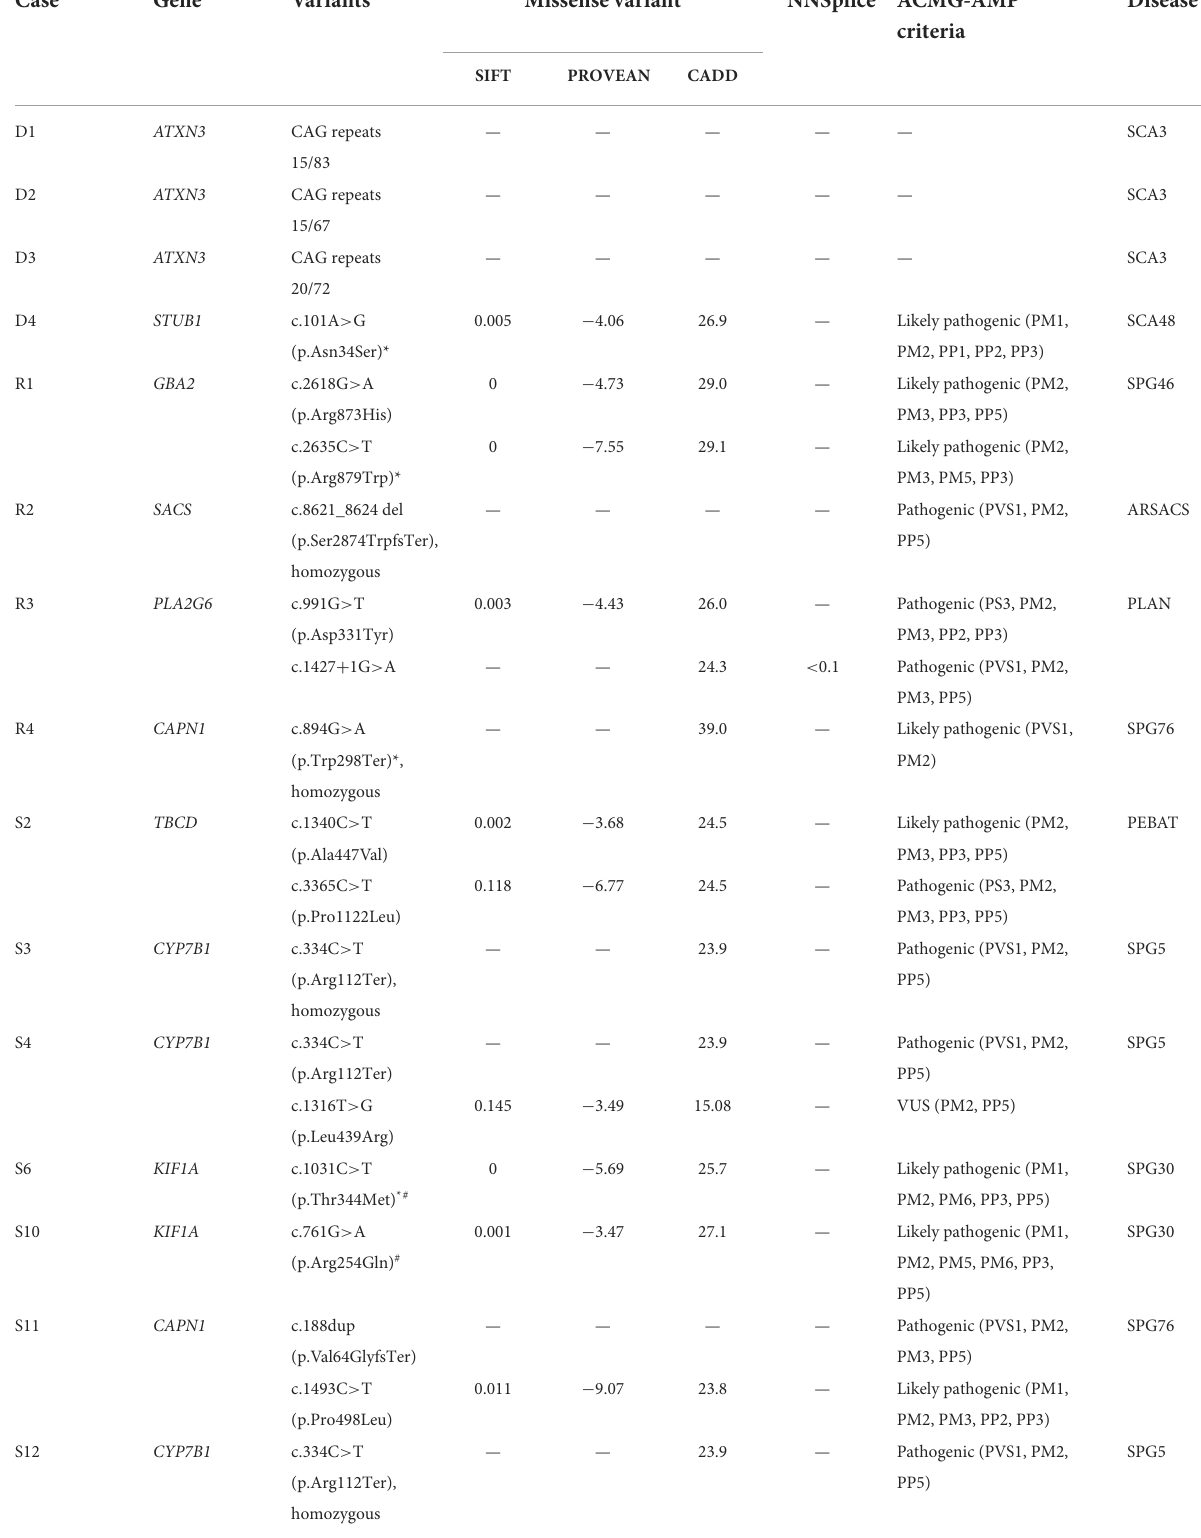
TABLE 2 Causative and likely causative genetic variants identified in the study